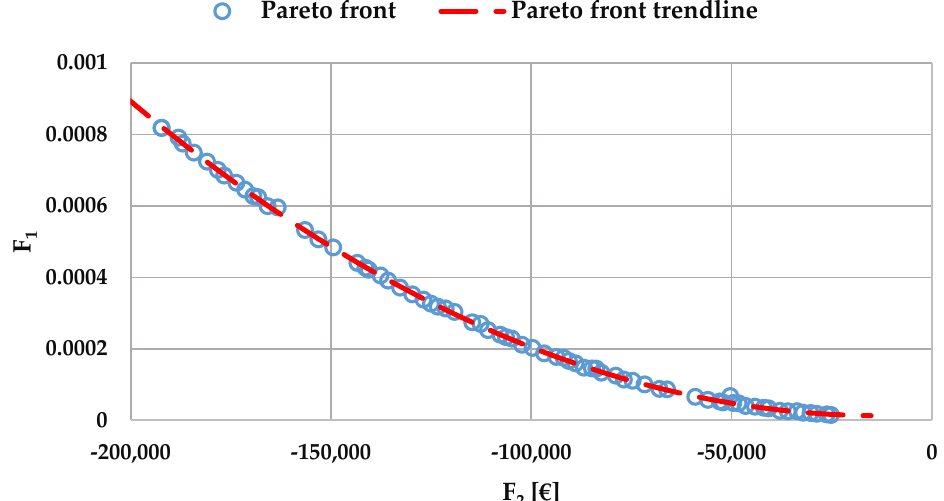
Figure 5. Pareto front for the daily operation of the storage.